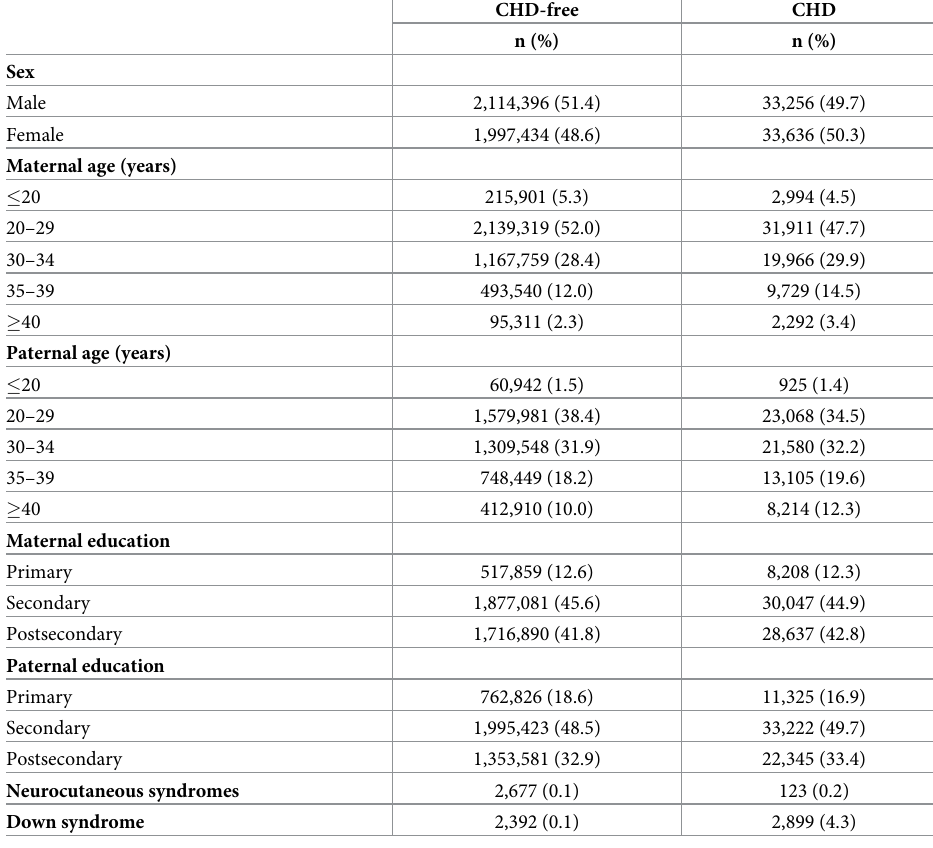
Table 1. Baseline characteristics of the study cohort by CHD status.